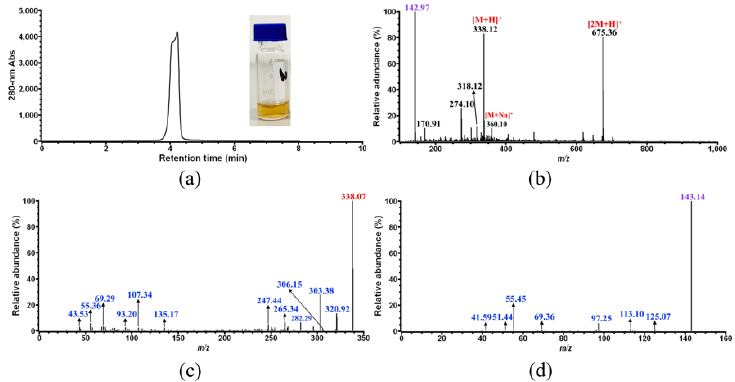
Figure 3. Identification of CP compound 2 . ( a ) HPLC analysis and photo of the concentrated sample of compound 2 ; ( b ) MS analysis of the concentrated sample of compound 2 ; ( c ) MS/MS analysis of the ion with m / z 383.12 obtained in ( b ); ( d ) MS/MS analysis of the ion with m / z 142.97 obtained in ( b ).